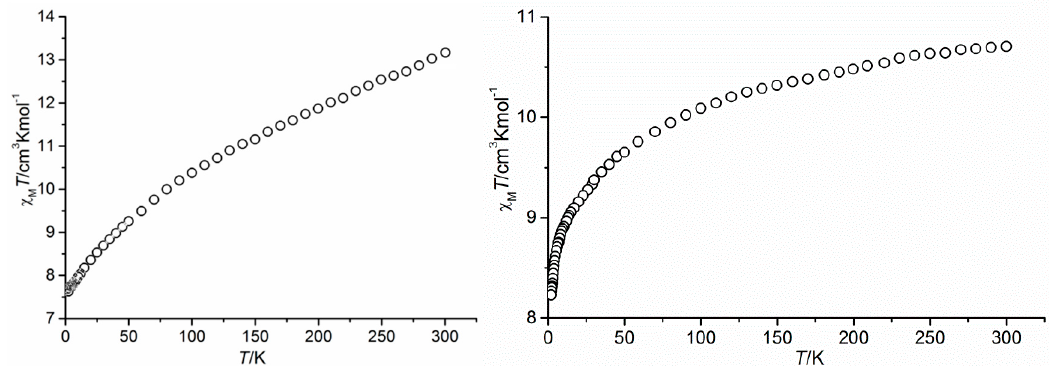
Figure 3. χ M T vs. T for DyH 2 daps : ( left ) a fresh sample, recorded from 300 to 2 K; ( right ) a fresh sample, recorded from 2 to 300 K.